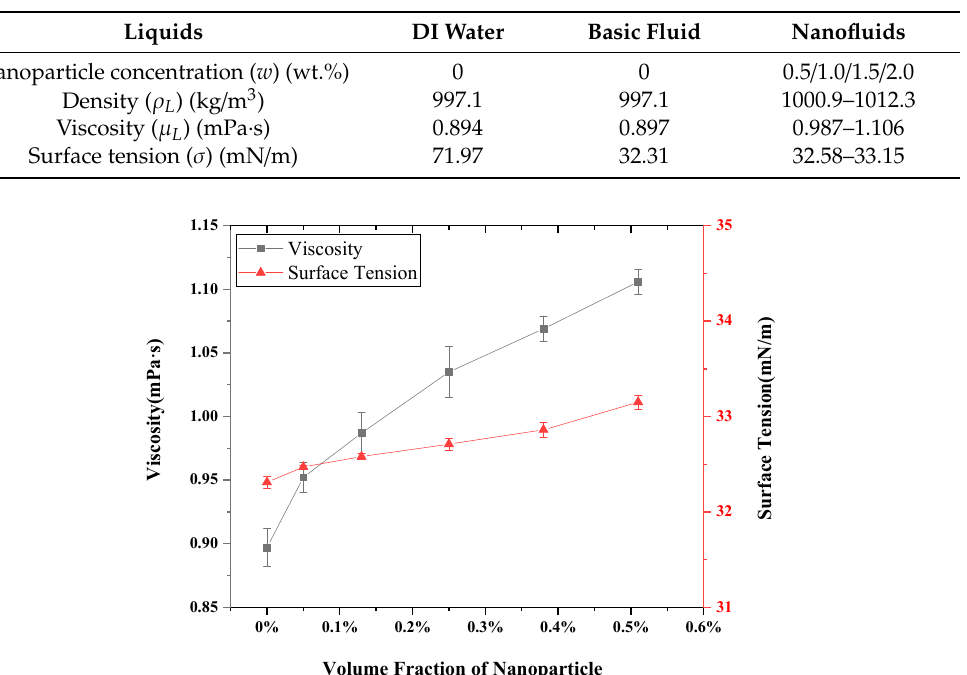
Table 1. Liquid properties (298 K, 101 kPa).